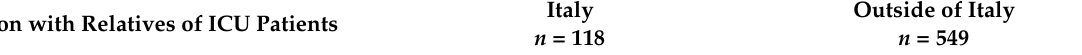
Table 3. Communication strategies with relatives in Italy and outside of Italy at the time of the survey. Percentages do not sum up to 100% as participants could select multiple